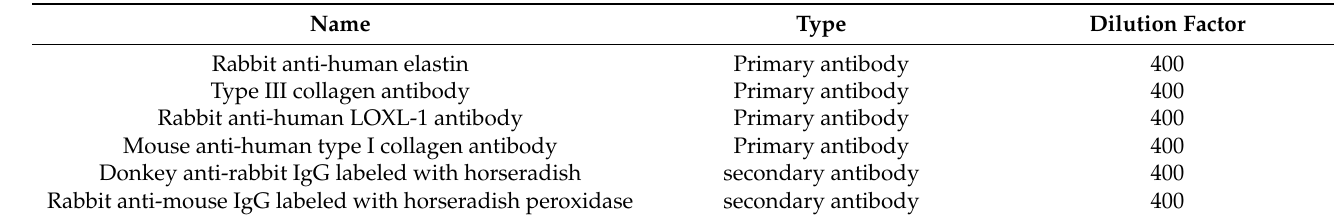
Table 1. Instructions for use of antibody.